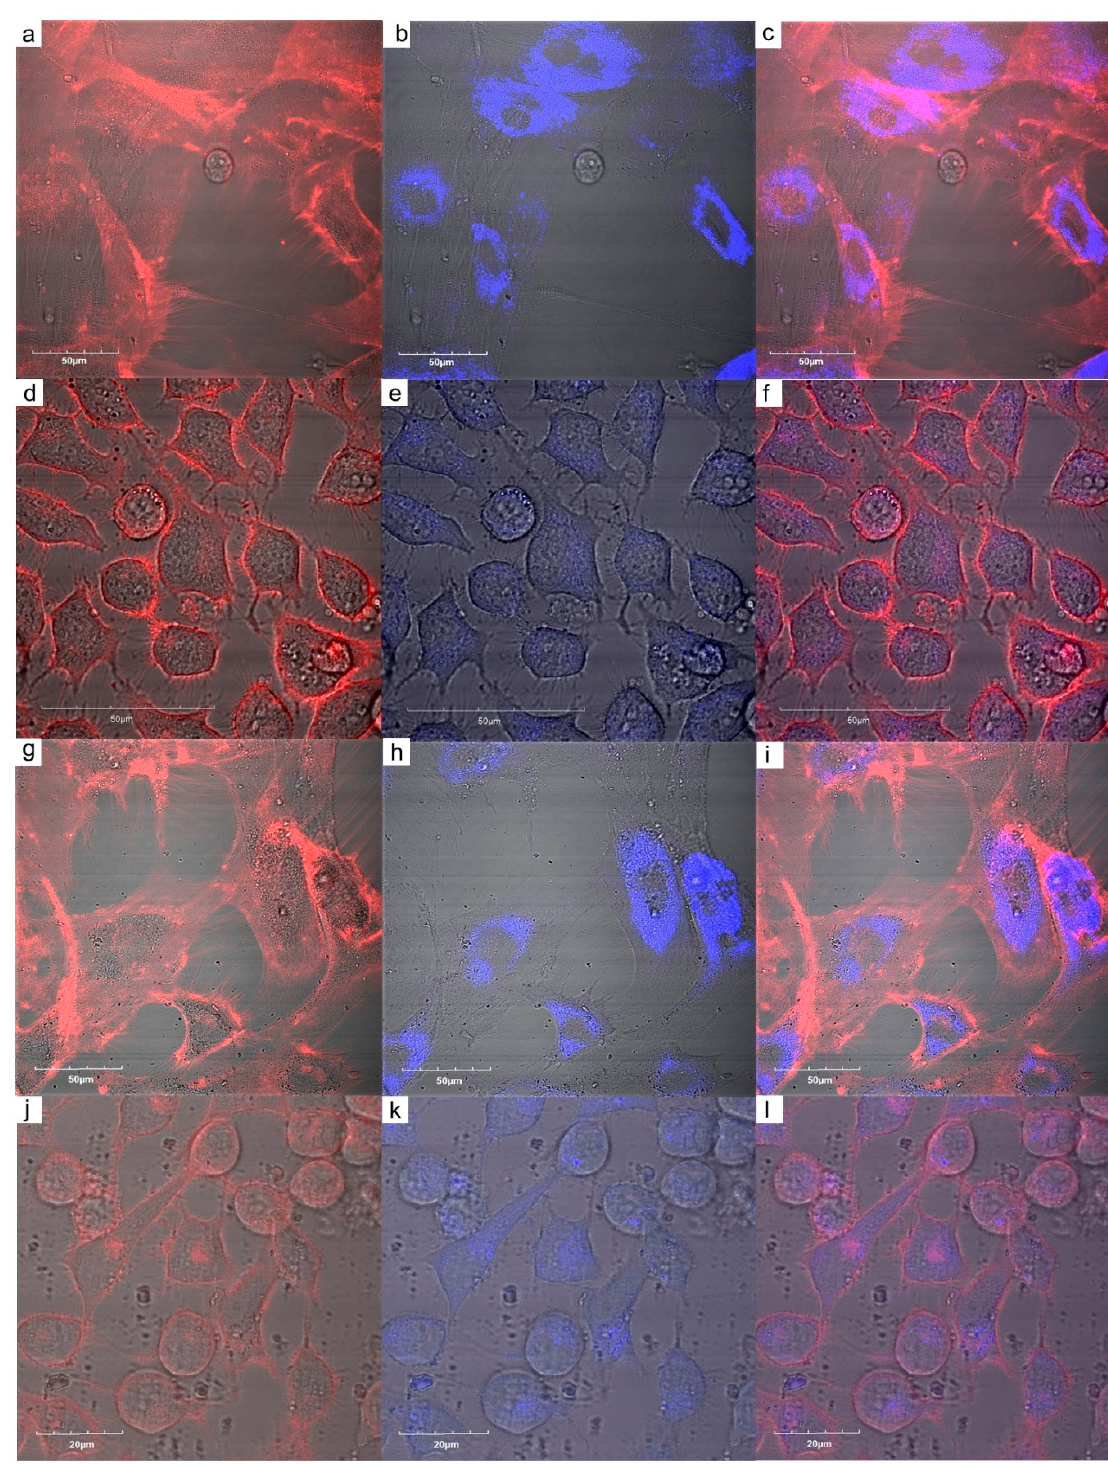
Figure 6. Intracellular uptake of ( a – f ) TbF 3 :Gd 3+ ,Yb 3+ ,Nd 3+ @P(DMA-AGME)-Ale and ( g – l ) GdF 3 :Tb 3+ ,Yb 3+ ,Nd 3+ @P(DMA- AGME)-Ale nanoparticles by ( d – f , j – l ) Hela and ( a – c , g – i ) HF cells. ( a , d , g , j ) CellMask™ deep red-stained cell membranes were visualized in red channel and ( b , e , h , k ) nanoparticles were visualized in blue channel. ( c , f , i , l ) Both channels were merged.